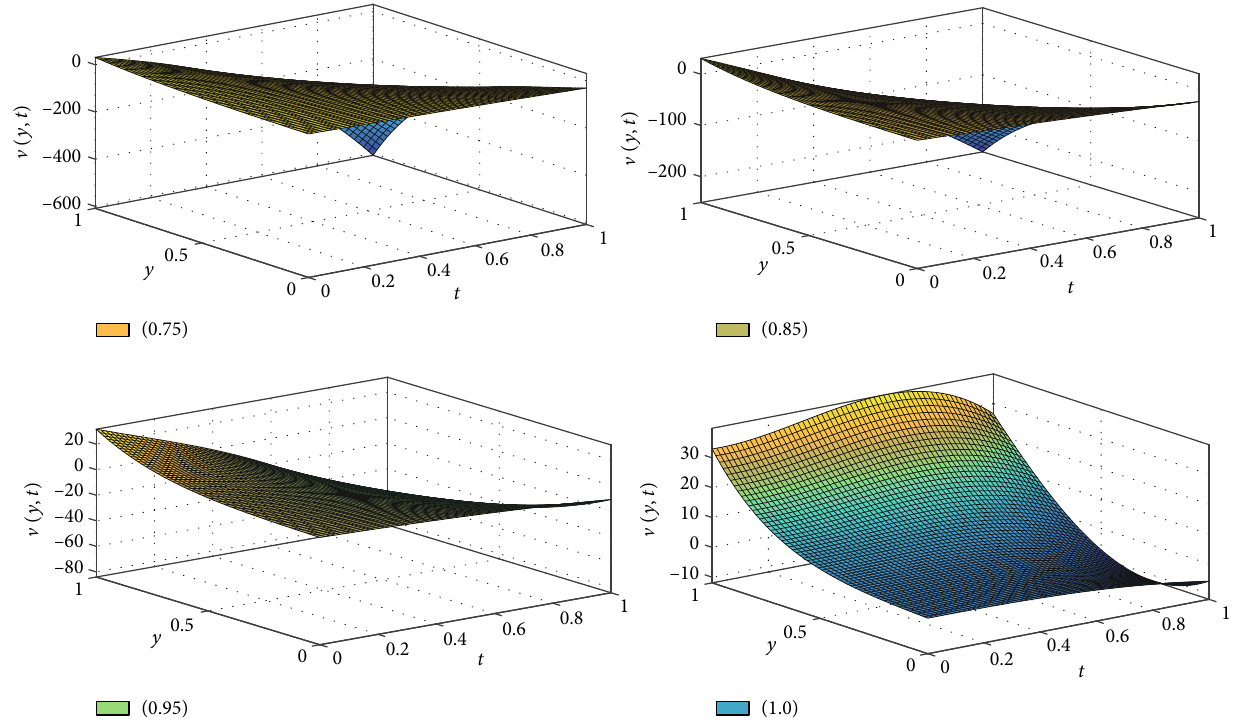
Figure 3: Surface plots of the resultant solution up to four terms at di ff erent values of γ for Example